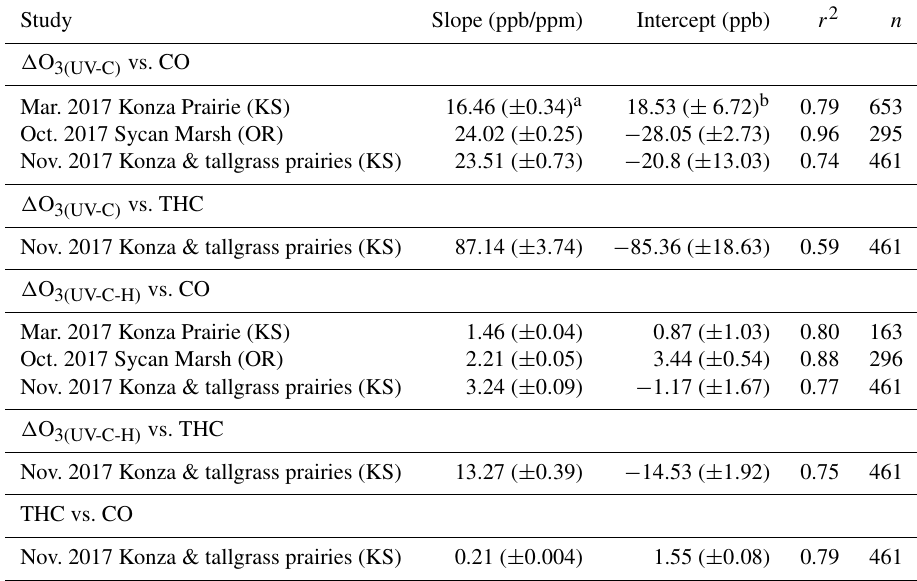
Table 4. Regression statistics for the ozone artifact ( (cid:49) O 3 ) versus CO and THC for UV photometric instruments without (UV-C) and with (UV-C-H) a Nafion ® -based humidity equilibration system during the 2017 prescribed grassland burns. Study Slope (ppb/ppm) Intercept (ppb) r 2 n (cid:49) O 3(UV-C) vs. CO Mar. 2017 Konza Prairie (KS) 16.46 ( ± 0 . 34) a 18.53 ( ± 6.72) b 0.79 653 Oct. 2017 Sycan Marsh (OR) 24.02 ( ± 0 . 25) − 28 . 05 ( ± 2 . 73) 0.96 295 Nov. 2017 Konza & tallgrass prairies (KS) 23.51 ( ± 0 . 73) − 20 . 8 ( ± 13 . 03) 0.74 461 (cid:49) O 3(UV-C) vs. THC Nov. 2017 Konza & tallgrass prairies (KS) 87.14 ( ± 3 . 74) − 85 . 36 ( ± 18 . 63) 0.59 461 (cid:49) O 3(UV-C-H) vs. CO Mar. 2017 Konza Prairie (KS) 1.46 ( ± 0 . 04) 0.87 ( ± 1 . 03) 0.80 163 Oct. 2017 Sycan Marsh (OR) 2.21 ( ± 0 . 05) 3.44 ( ± 0 . 54) 0.88 296 Nov. 2017 Konza & tallgrass prairies (KS) 3.24 ( ± 0 . 09) − 1 . 17 ( ± 1 . 67) 0.77 461 (cid:49) O 3(UV-C-H) vs. THC Nov. 2017 Konza & tallgrass prairies (KS) 13.27 ( ± 0 . 39) − 14 . 53 ( ± 1 . 92) 0.75 461 THC vs. CO 0.21 ( ± 0 . 004) 1.55 ( ± 0 . 08) 0.79